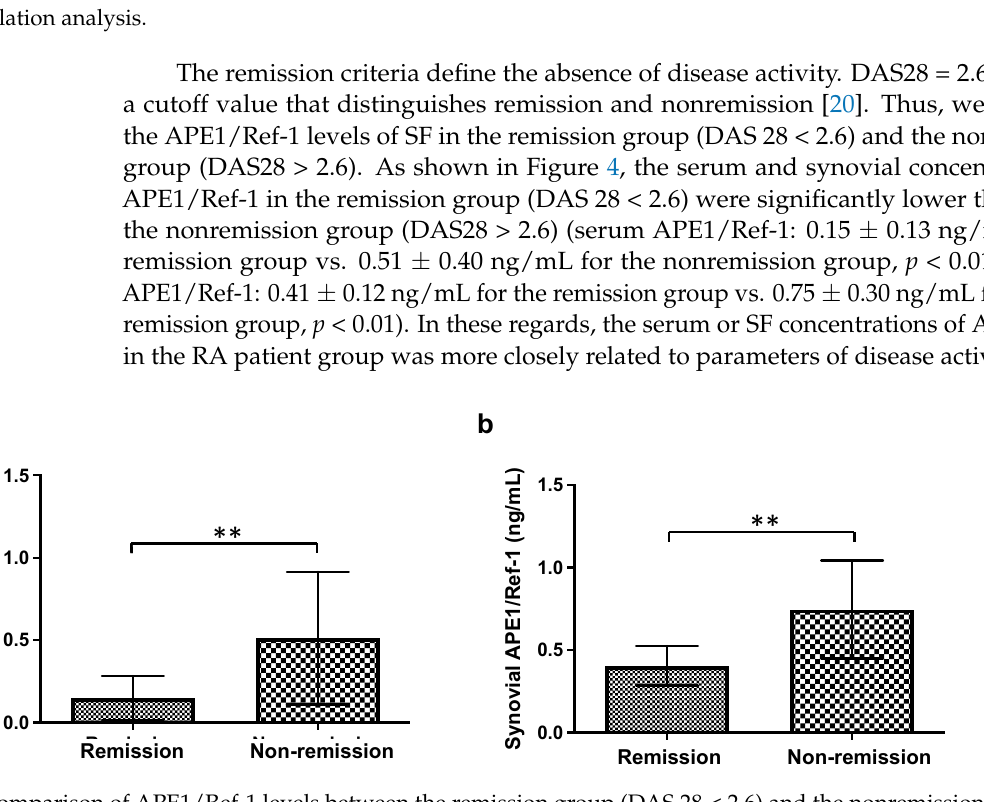
Figure 4. The comparison of APE1/Ref-1 levels between the remission group (DAS 28 < 2.6) and the nonremission group (DAS 28 > 2.6). ( a ) The serum APE1/Ref-1 concentration of the remission group ( n = 6) and the nonremission group ( n = 23). ( b ) The synovial APE1/Ref-1 concentration of the remission group ( n = 6) and the nonremission group ( n = 25). Columns represent the mean; bars represent the SD. ** p < 0.01, vs. remission according to an unpaired t -test.